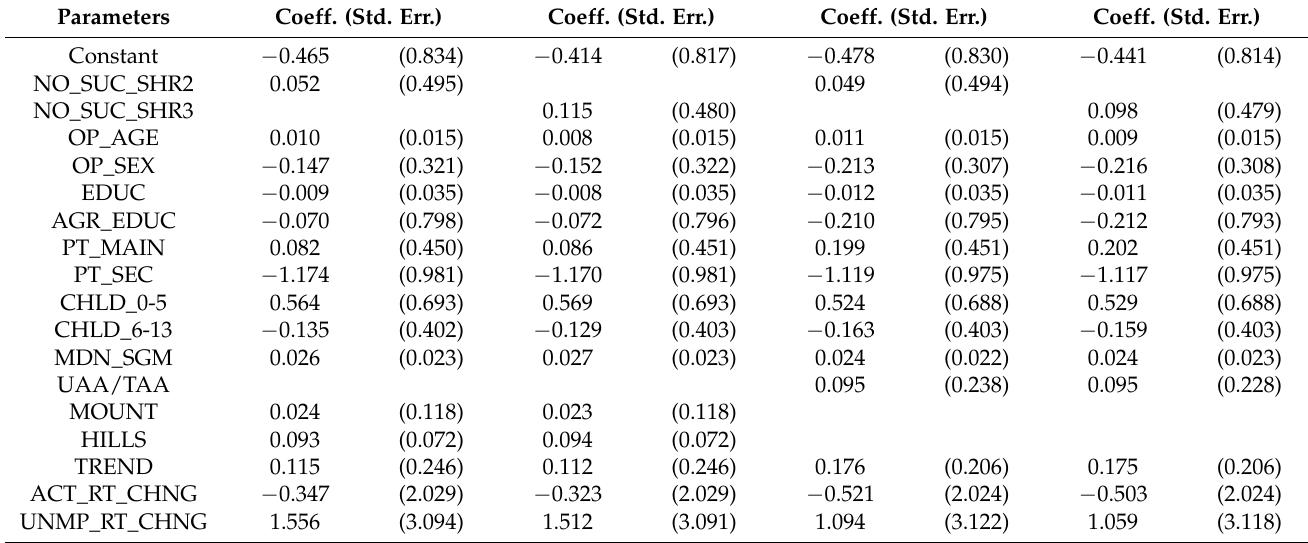
Table A6. Parameter estimates of different UAA decrease rate models using the family farms database.